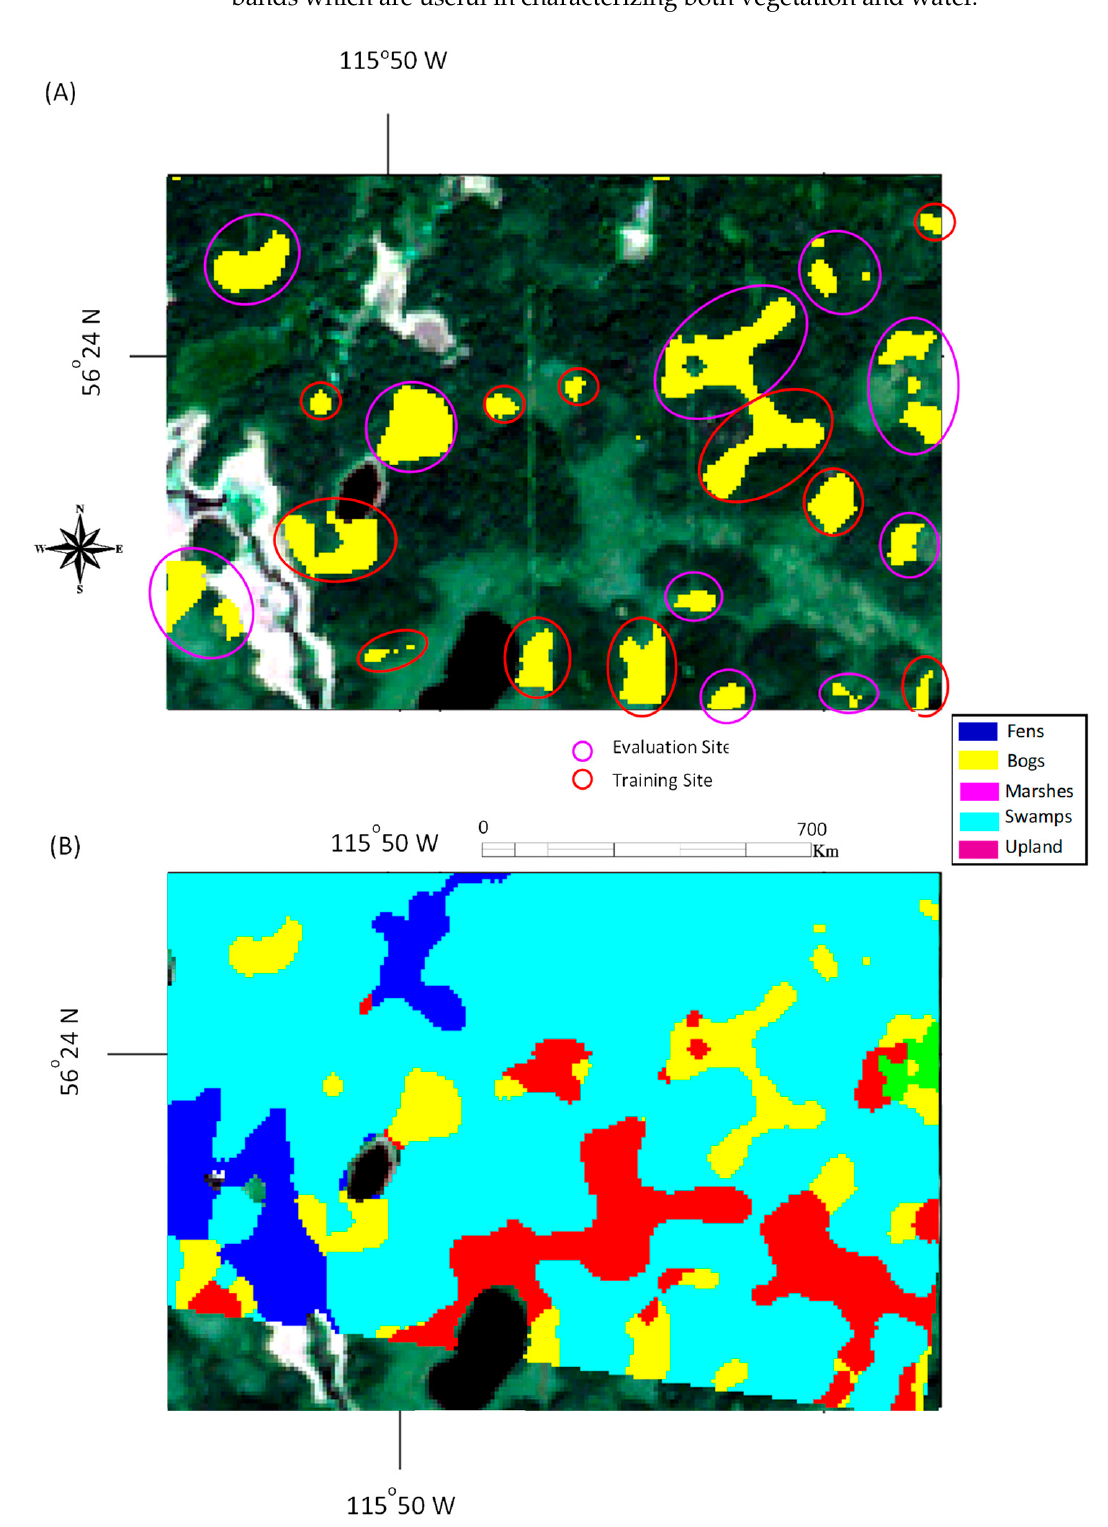
Figure 2. Example of a study area highlighting the individual evaluation and training sets for swamps ( A ) and its corresponding cover type map (ground truth) ( B ) .